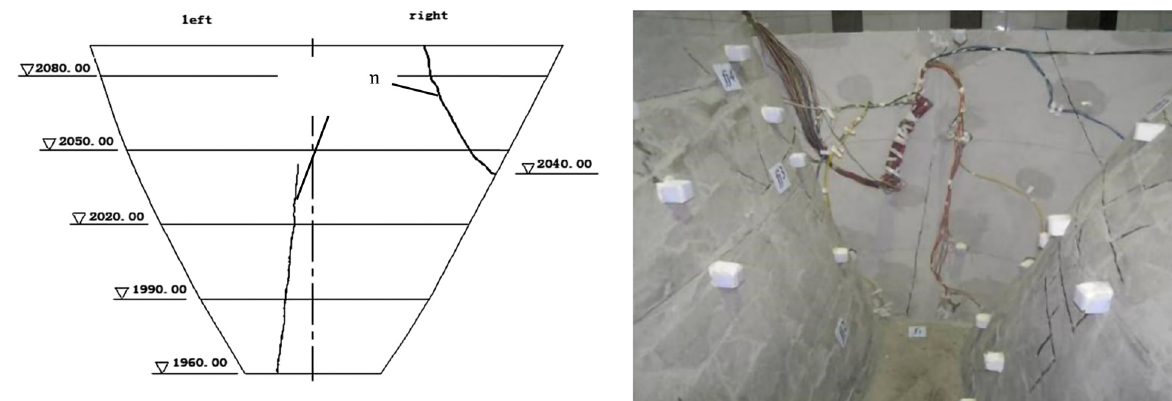
Figure 12: The fi nal failure mode of the dam.